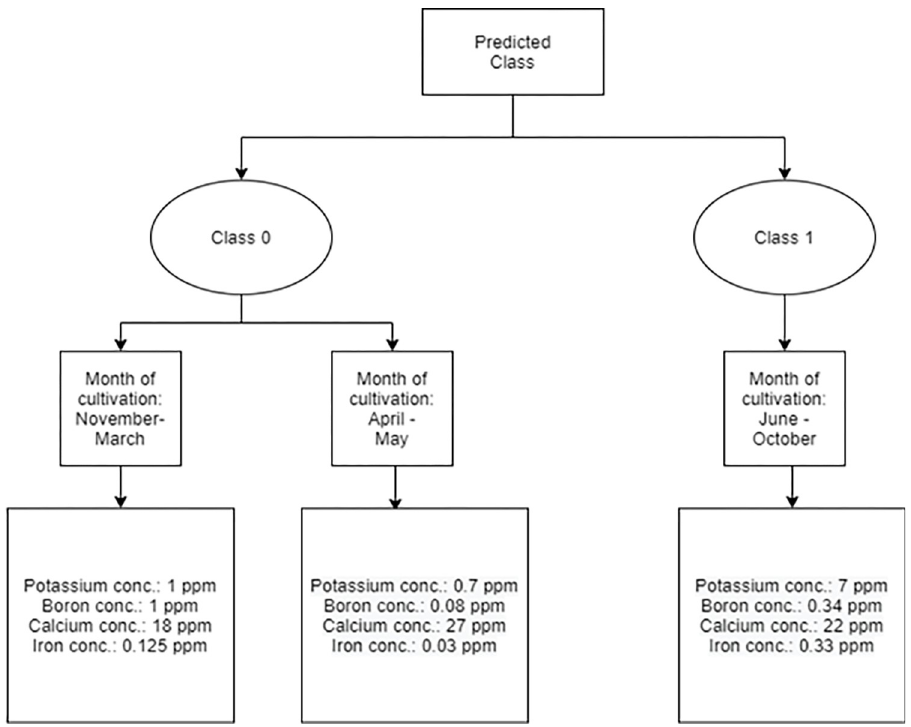
Fig 7. Decision tree stating the recommended rules based on the output from the Machine Learning